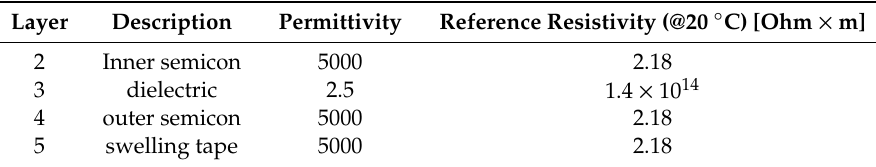
Table 2. Electrical properties of the cable taken as the case